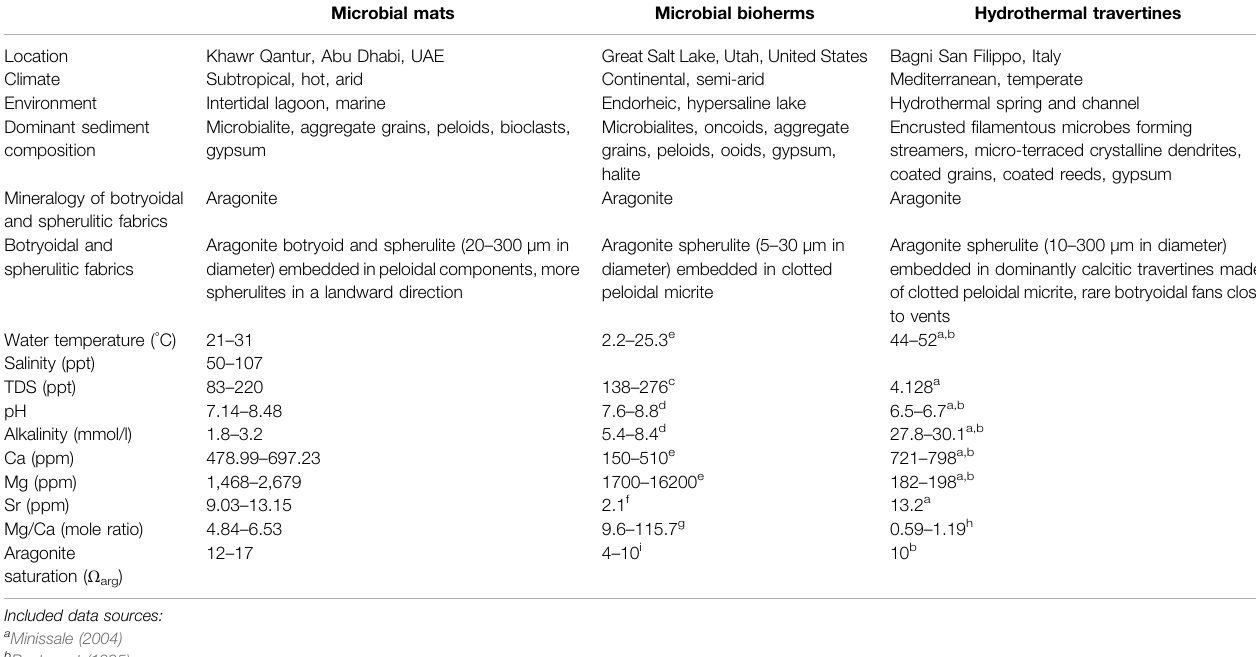
TABLE 1 | Sediment and water properties (temperature, salinity, TDS, pH, alkalinity, Ca, Mg, Sr, Mg/Ca and aragonite saturation) of the three study